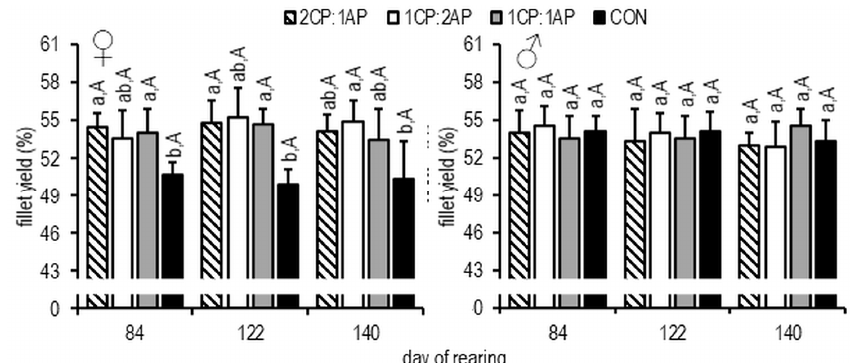
Figure 5. Fillet yield (%) of brook trout reared under three non-circadian photoperiods (see Figure 1 for details). Data are mean (bars) ± SD—standard deviation (whiskers). Different small letters indicate significant difference among treatments at a sample date ( p < 0.05) and different big letters indicate significant difference within the experiment group at a different sampling date ( p < 0.05). 2CP:1AP—group exposed to 24 h of ambient photoperiod alternating with a 48 h of continuous light, 1CP:2AP—group exposed to 48 h of ambient photoperiod alternating with a 24 h of continuous light, 1CP:1AP—group exposed to 24 h of ambient photoperiod alternating with 24 h of continuous light, CON—group exposed to natural ambient photoperiod as a control.